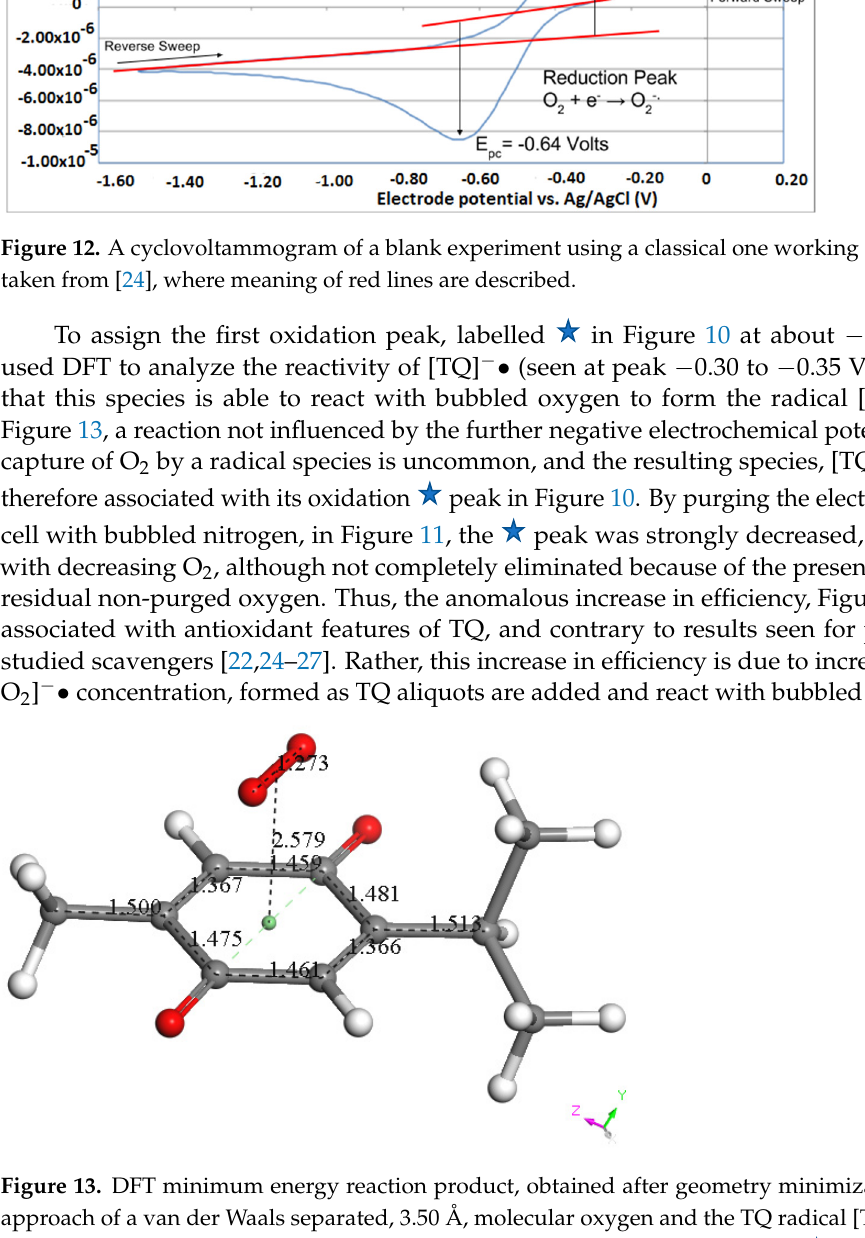
Figure 11. CV of TQ 0.00074 M solution (1280 µL aliquot) purged with N 2 gas showing evidence of incomplete purging of the O 2 . The collection efficiency for the TQ RRDE experiment (Figure 8) is anomalous, showing an initial decrease in efficiency through the first four TQ additions (as normally observed), but then the efficiency increased with each further addition of TQ aliquot, which has never been observed in previous studies [22,24,25,26,27]. To clarify